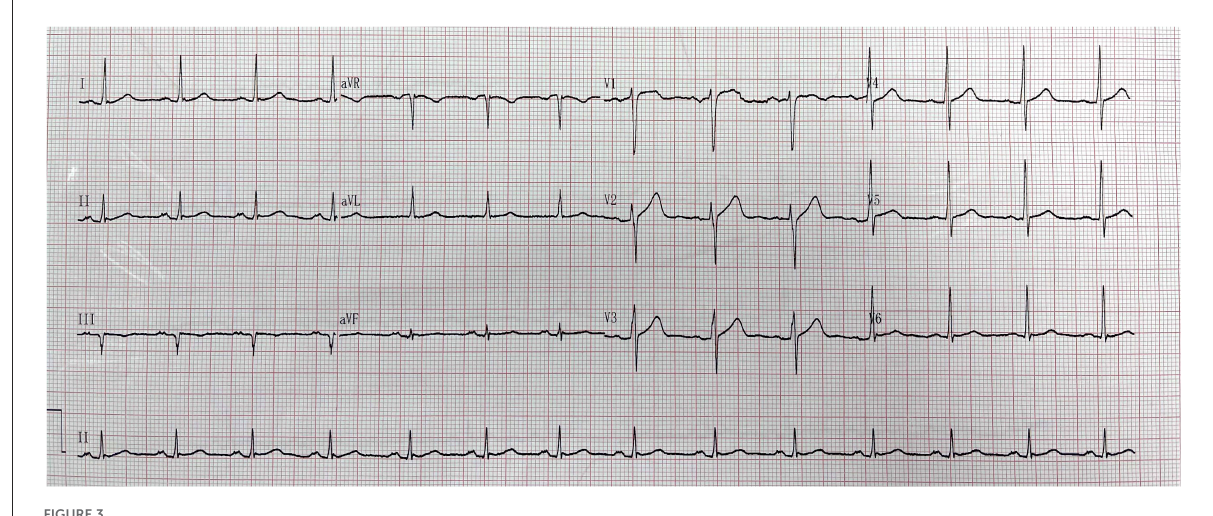
FIGURE3 Emergency electrocardiogram in July 2021.